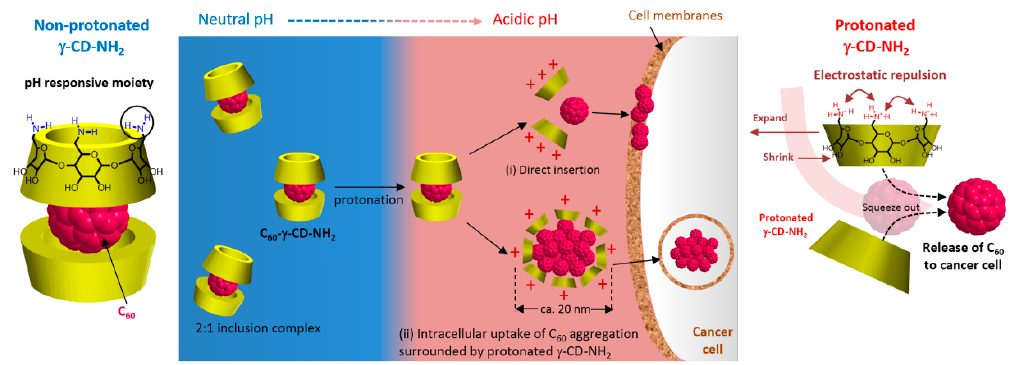
Figure 66. Schematic representation of efficient cellular uptake mechanisms and 2:1 C 60 - γ -CD-NH 2 inclusion complex under neutral and acidic pH. Adapted from Nobusawa; Akiyama; Ikeda; Naito [216].